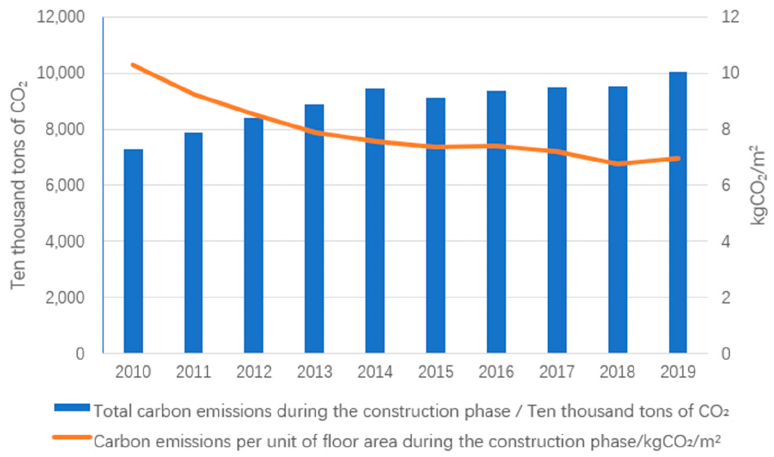
Figure 2. Average level of carbon emissions during the construction phase of buildings in China. (2) Energy consumption and carbon emissions of each part of the project